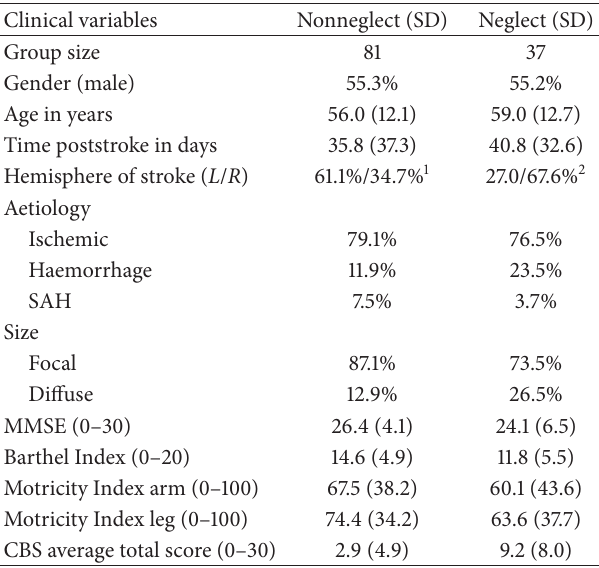
Table 1: Demographical and stroke characteristics per group (non- neglect versus neglect). Groups were made on the basis of perfor- mance of a shape cancellation